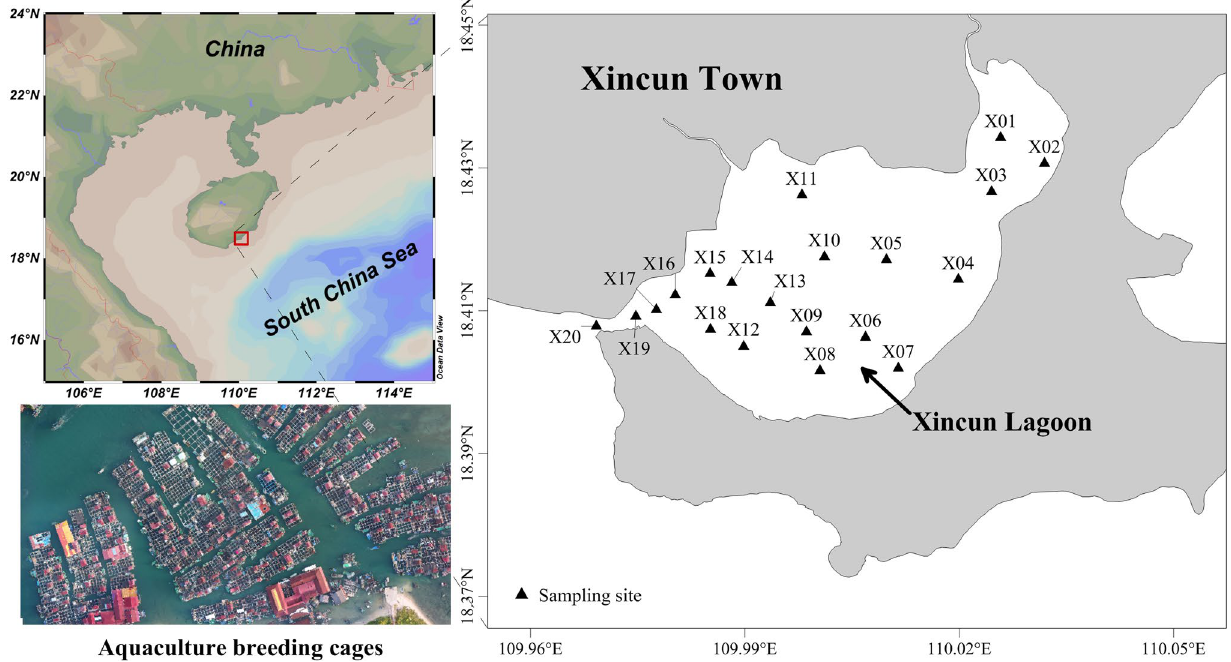
Figure 5. Map of study area and sampling sites in Xincun Lagoon, South China Sea. (Software: Ocean Data View 4. The map was obtained from the ODV software’s own map resources, Schlitzer, Reiner, Ocean Data View, odv.awi.de,